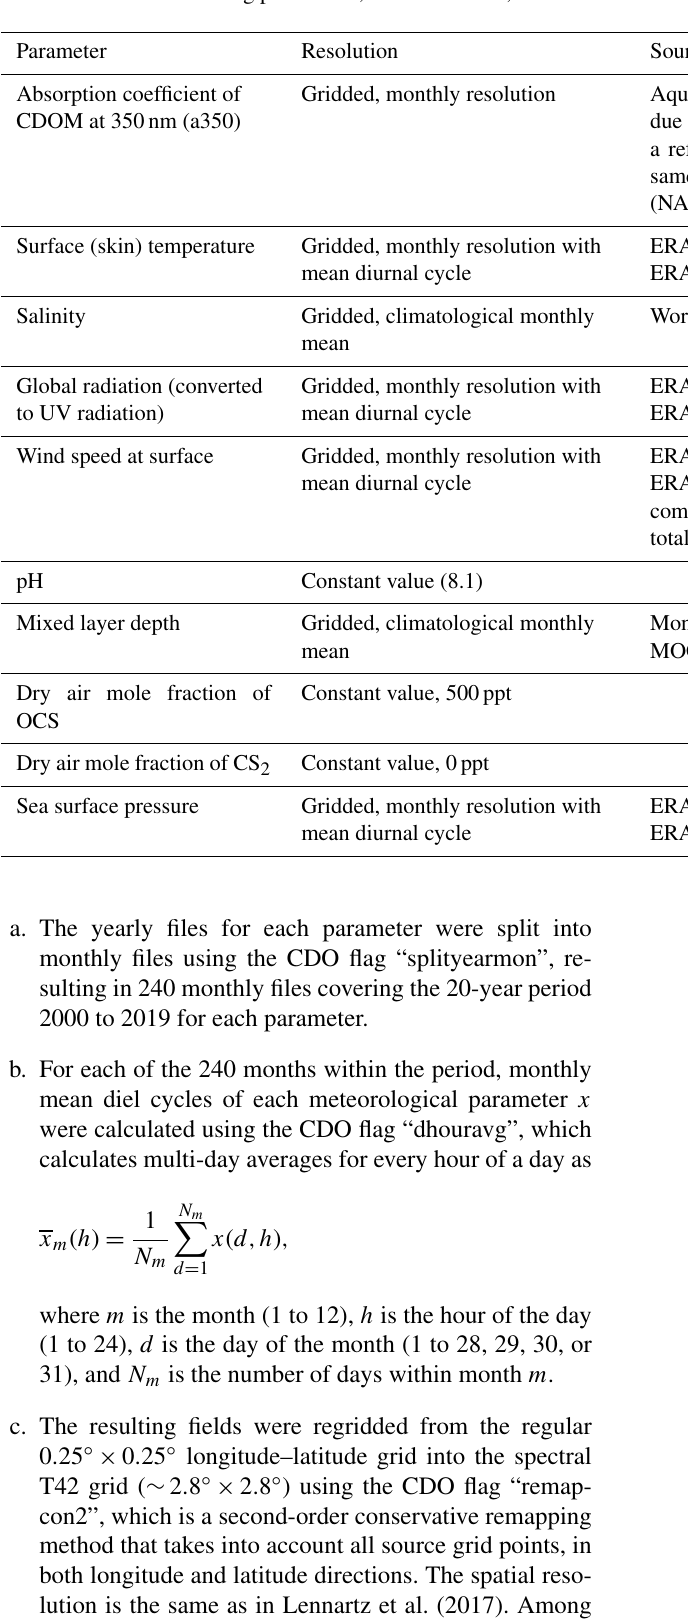
Table 1. Overview of forcing parameters, their resolution, and sources used for the box model simulations in the 2000–2019